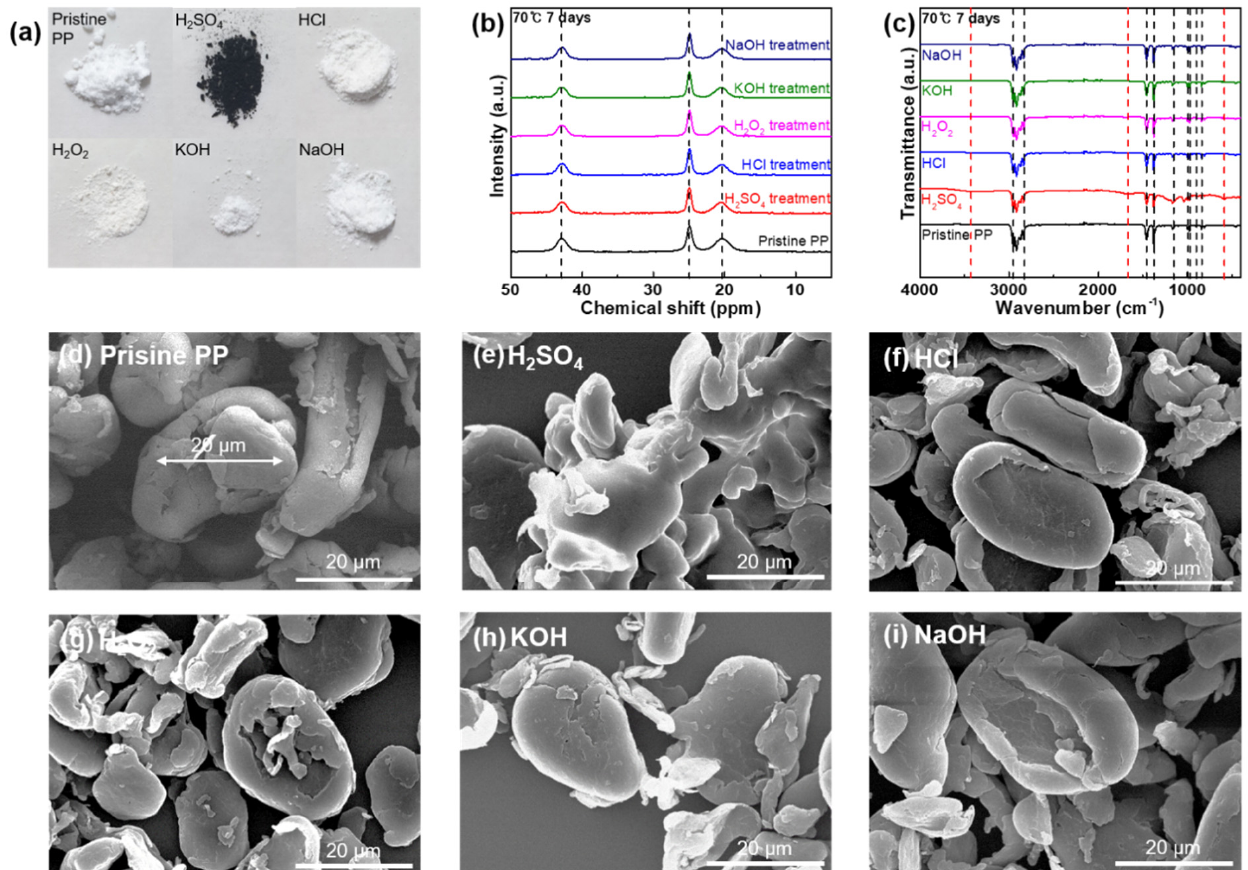
Figure 6. ( a ) Photograph of the PP samples in the pristine state and after chemical stability tests against strong acids, bases, and oxidizing agents (H 2 SO 4 , HCl, H 2 O 2 , KOH, and NaOH) used in the chemical digestion procedure at 70 °C for 7 d. ( b ) 13 C NMR spectra of PP in the pristine state and after the reaction with all chemical agents at 70 °C for 7 d. ( c ) FT-IR spectra of PP in the pristine state and after the reaction with all chemical agents at 70 °C for 7 d. ( d ) SEM image of pristine PP micro- particles. SEM images of PP microparticles after the reaction with ( e ) H 2 SO 4 , ( f ) HCl, ( g ) H 2 O 2 , ( h ) KOH, and ( i ) NaOH at 70 °C for 7 d.